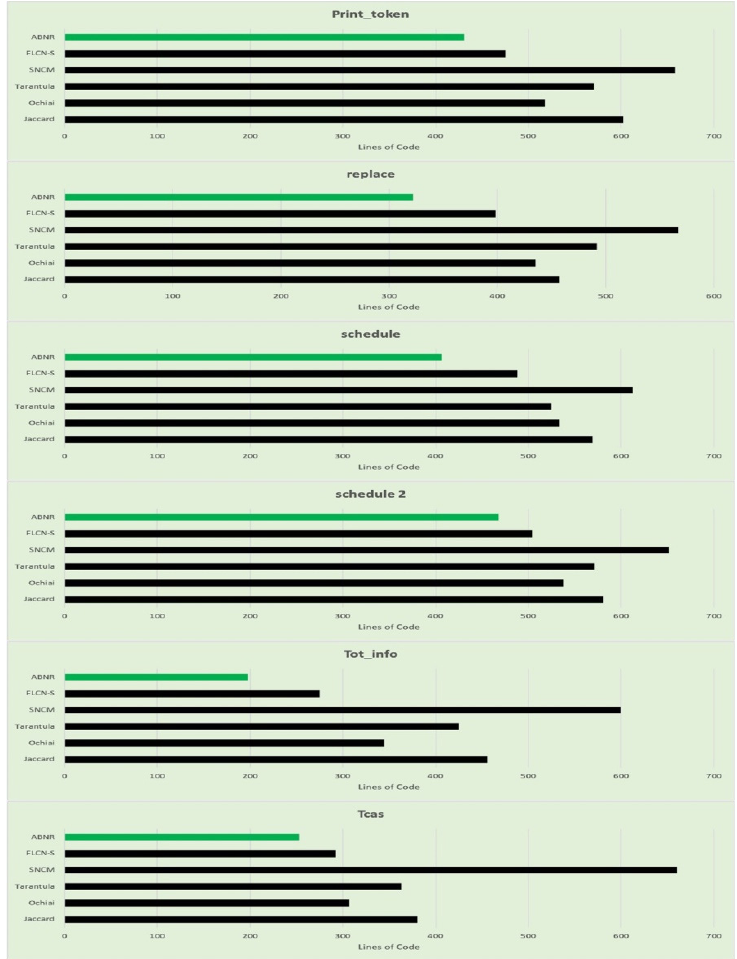
Figure 5. Graphs representing the number lines of code evaluated for fault localization for each category in Siemen ’ s validation set .